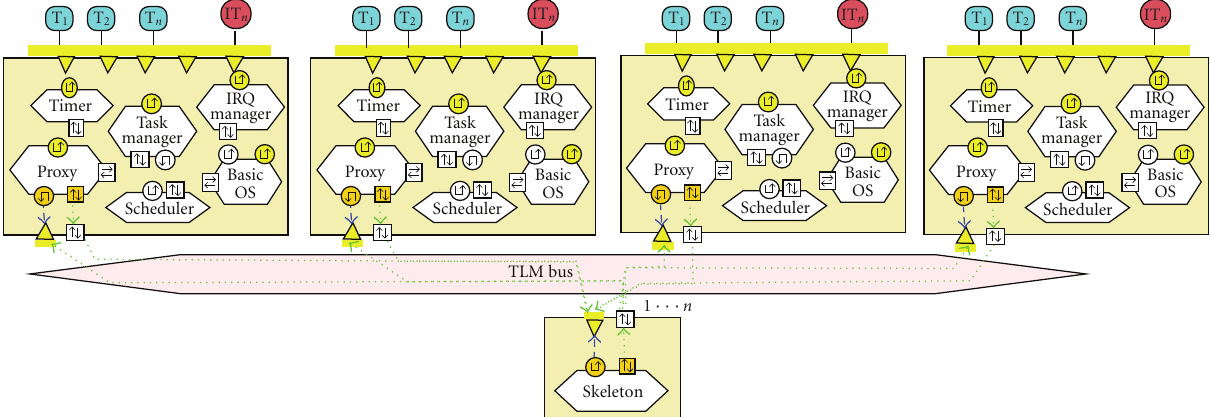
Figure 8: Model of MPSoC RTOSes with a hardware shared semaphore service. Each RTOS has a local Proxy service which forwards a (semaphore) request to an external device (the skeleton ) that processes the real service, as a RPC (Remote Procedure Call), except the skeleton services could be refined in hardware.